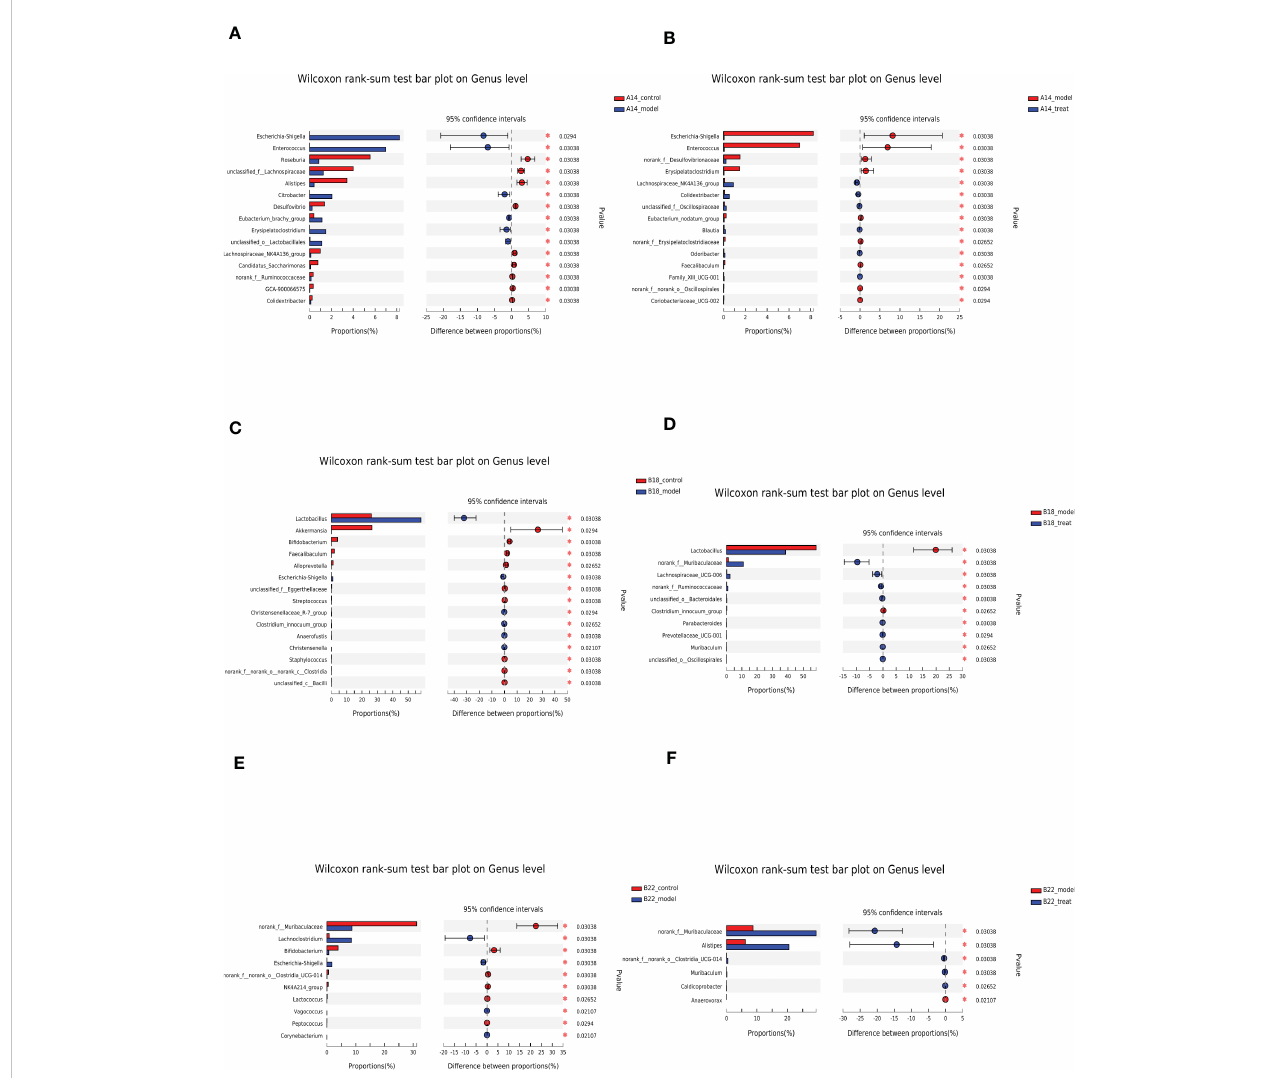
FIGURE 5 DAPA consistently remodels the gut microbiota composition of db/db mice at the genus level. (A, C, E) Signi fi cantly changed top 15 genera sorted by their abundances between the control group and model group at 14 weeks (14w), 18 weeks (18w), and 22 weeks (22w). (B, D, F) Signi fi cantly changed top 15 genera sorted by their abundances between the model group and model + DAPA group at 14w, 18w, and 22w. n=4/group. Statistical signi fi cance was calculated using Wilcoxon rank-sum test. *p < 0.05. The treat group means model + DAPA